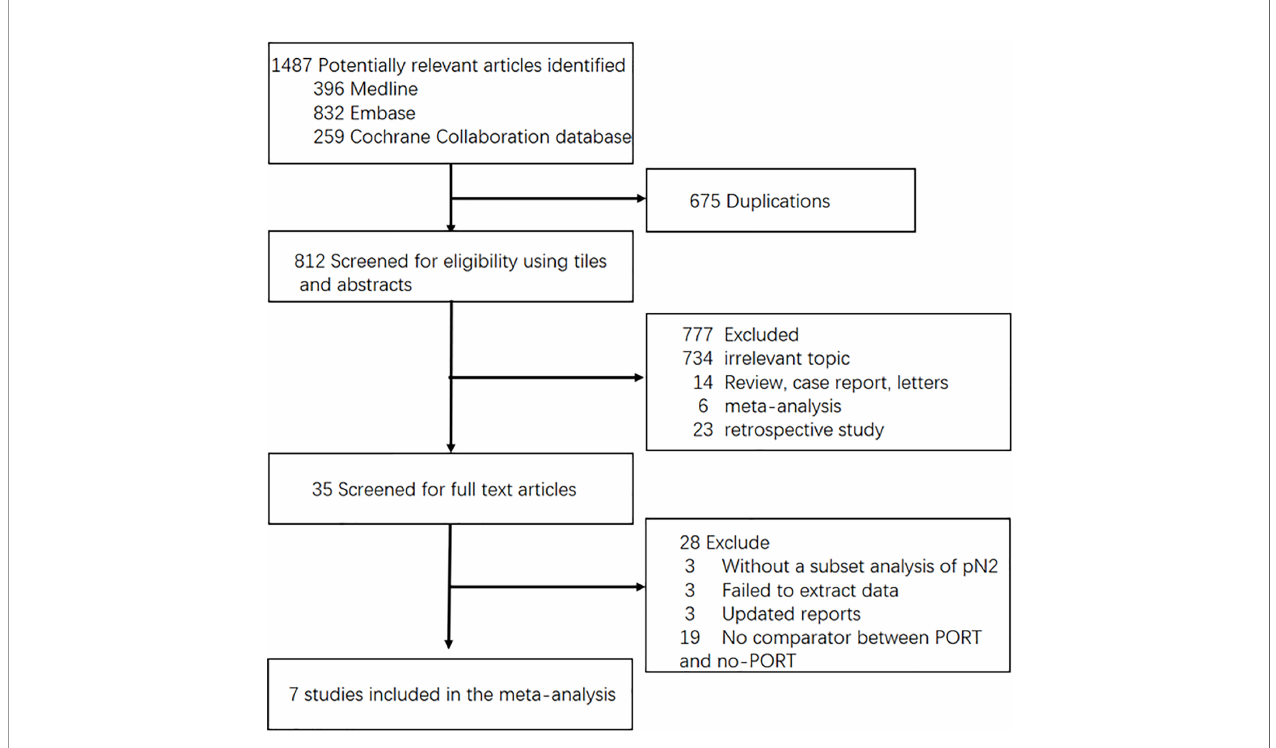
FIGURE 1 | Flow-chart of selecting RCTs for analysis. PORT, Post-operative